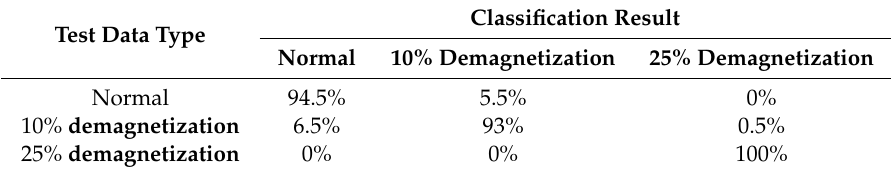
Table 10. Accuracy of test